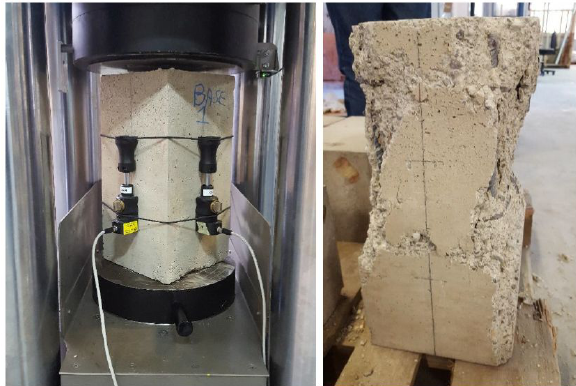
Figure 8: Compression test on sample of reinforced concrete col- umn: placement of strain gauges (left) and typical failure mode (right)